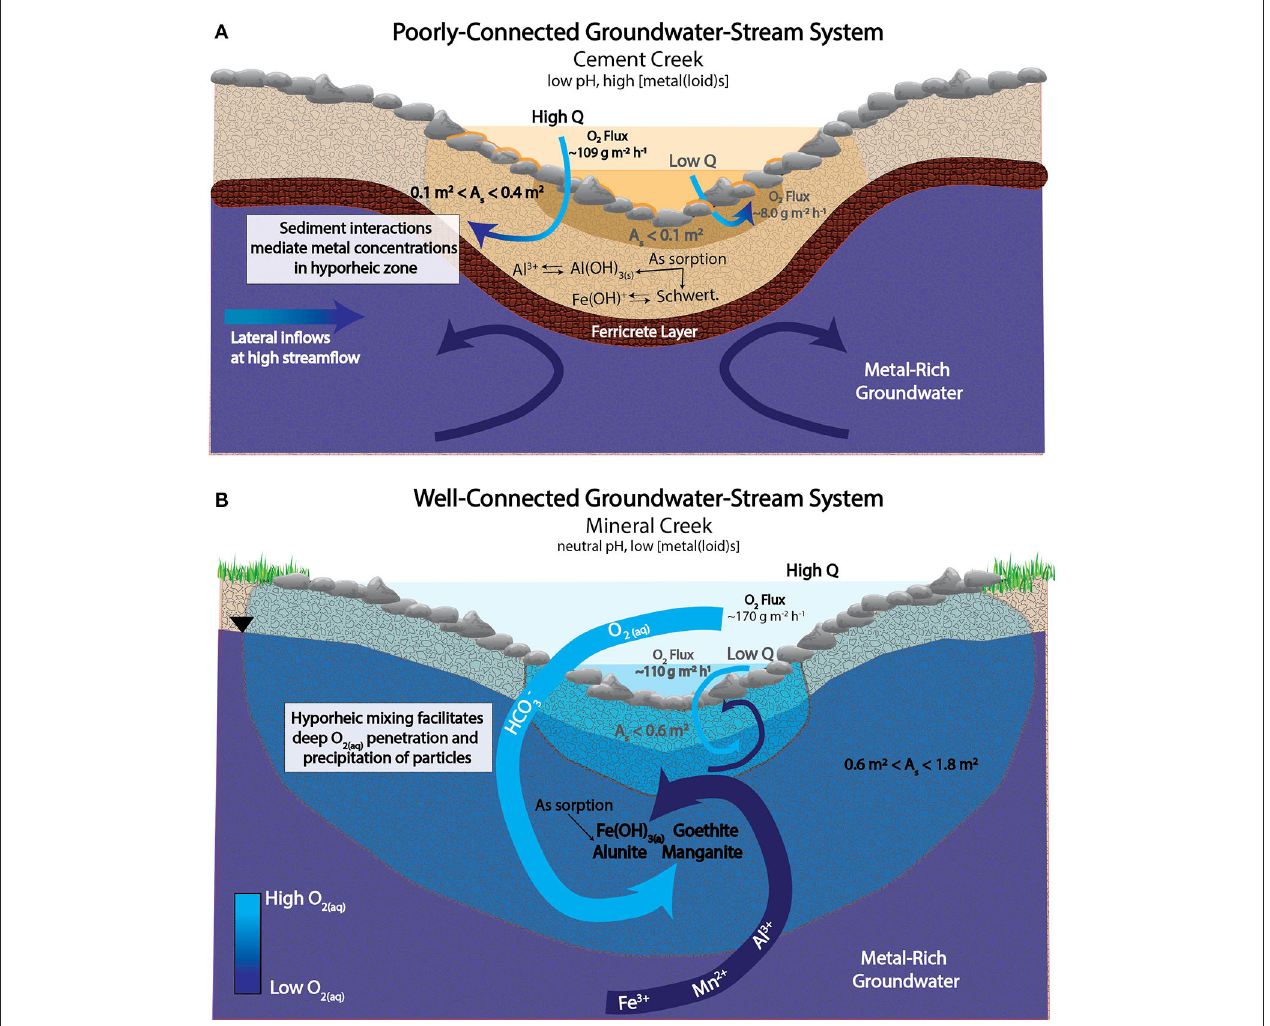
FIGURE 7 | Conceptual model for (A) a poorly connected stream–groundwater system at Cement Creek and (B) a well-connected groundwater–stream system at Mineral Creek. The color of the arrows corresponds to oxygen concentration, where light blue represents oxygenated waters and dark blue represents waters with low dissolved oxygen concentrations. The text in gray denotes low flow, and the text in black denotes high flow oxygen and transient storage conditions. The transient storage areas ( A s ) for the poorly connected and well-connected conceptual models are bounded by one-dimensional transport with inflow and storage model estimates. The exchange rate was the same order of magnitude at high and low flow for both systems ( α ∼ 0.001–0.005 s − 1